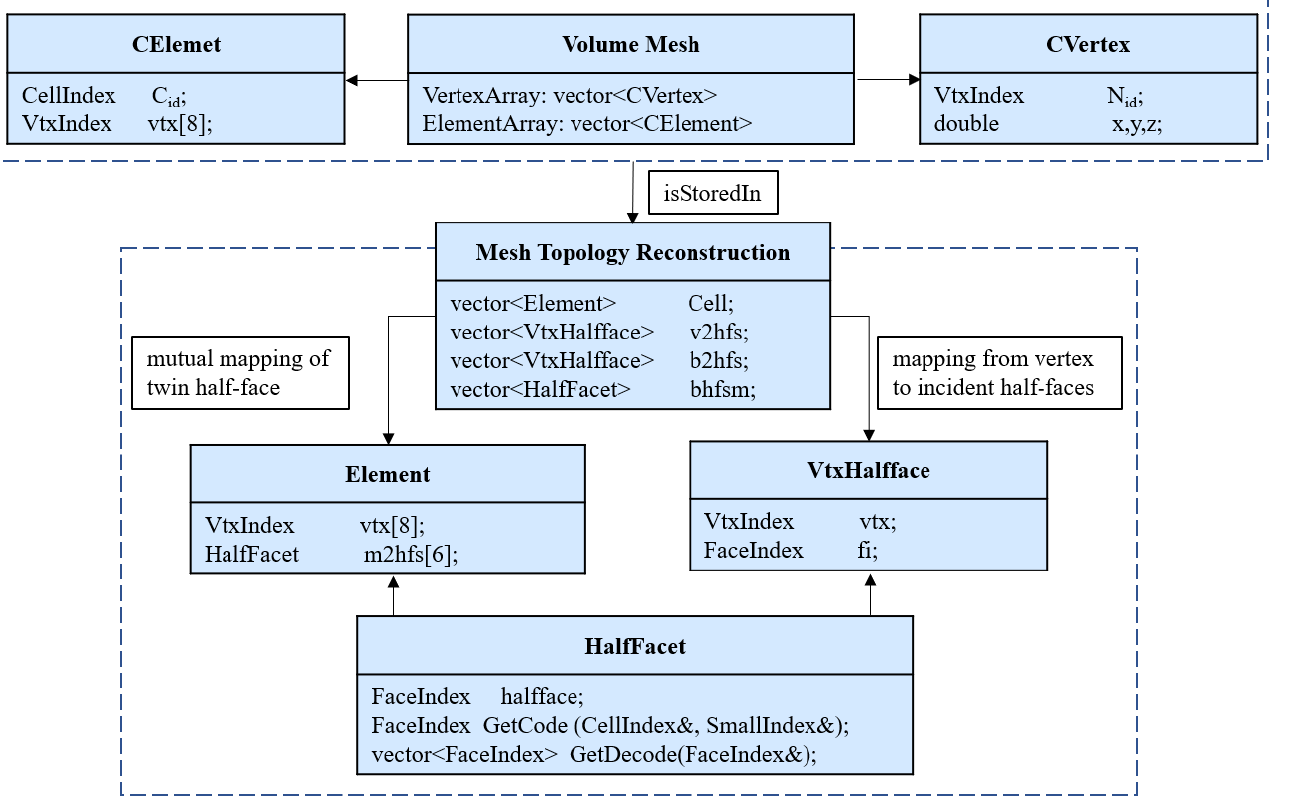
Algorithm 1 Construction of twin half-faces.